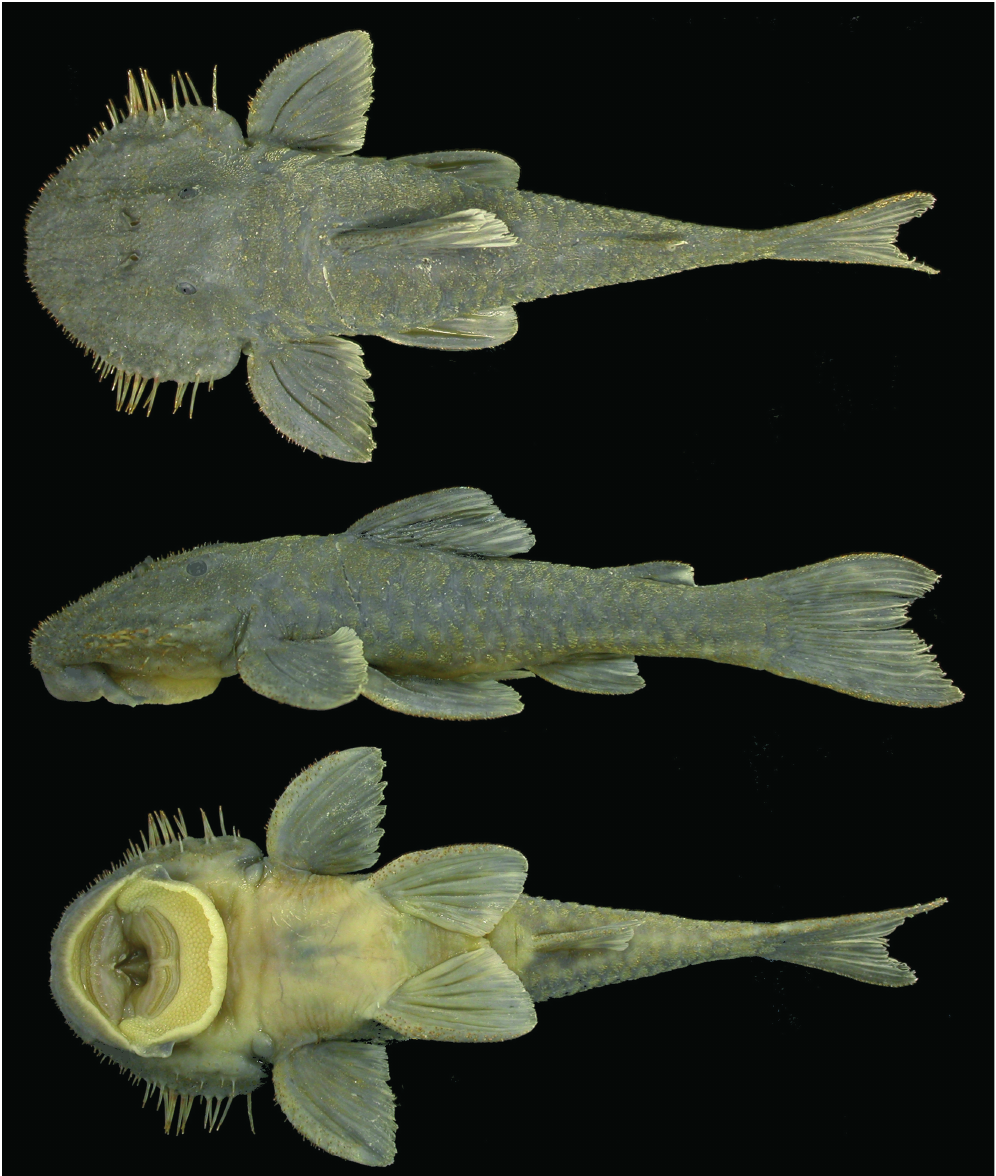
Fig. 1. Pareiorhaphis nasuta , holotype, male, MCP 41764, 78.6 mm SL. Brazil: Minas Gerais, ribeirão Areia Branca, tributary to the upper rio Matipó, rio Doce